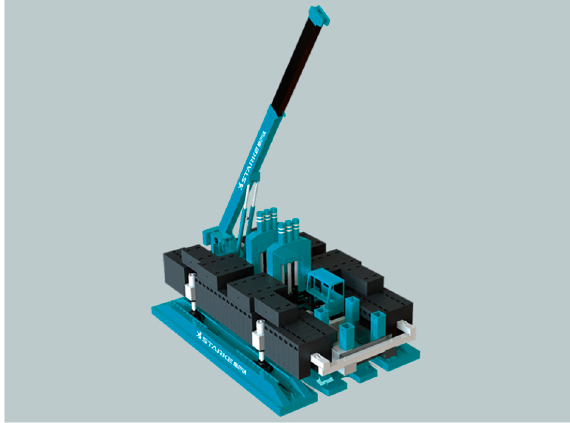
Figure 1. YZY400 hydraulic static pile driver.